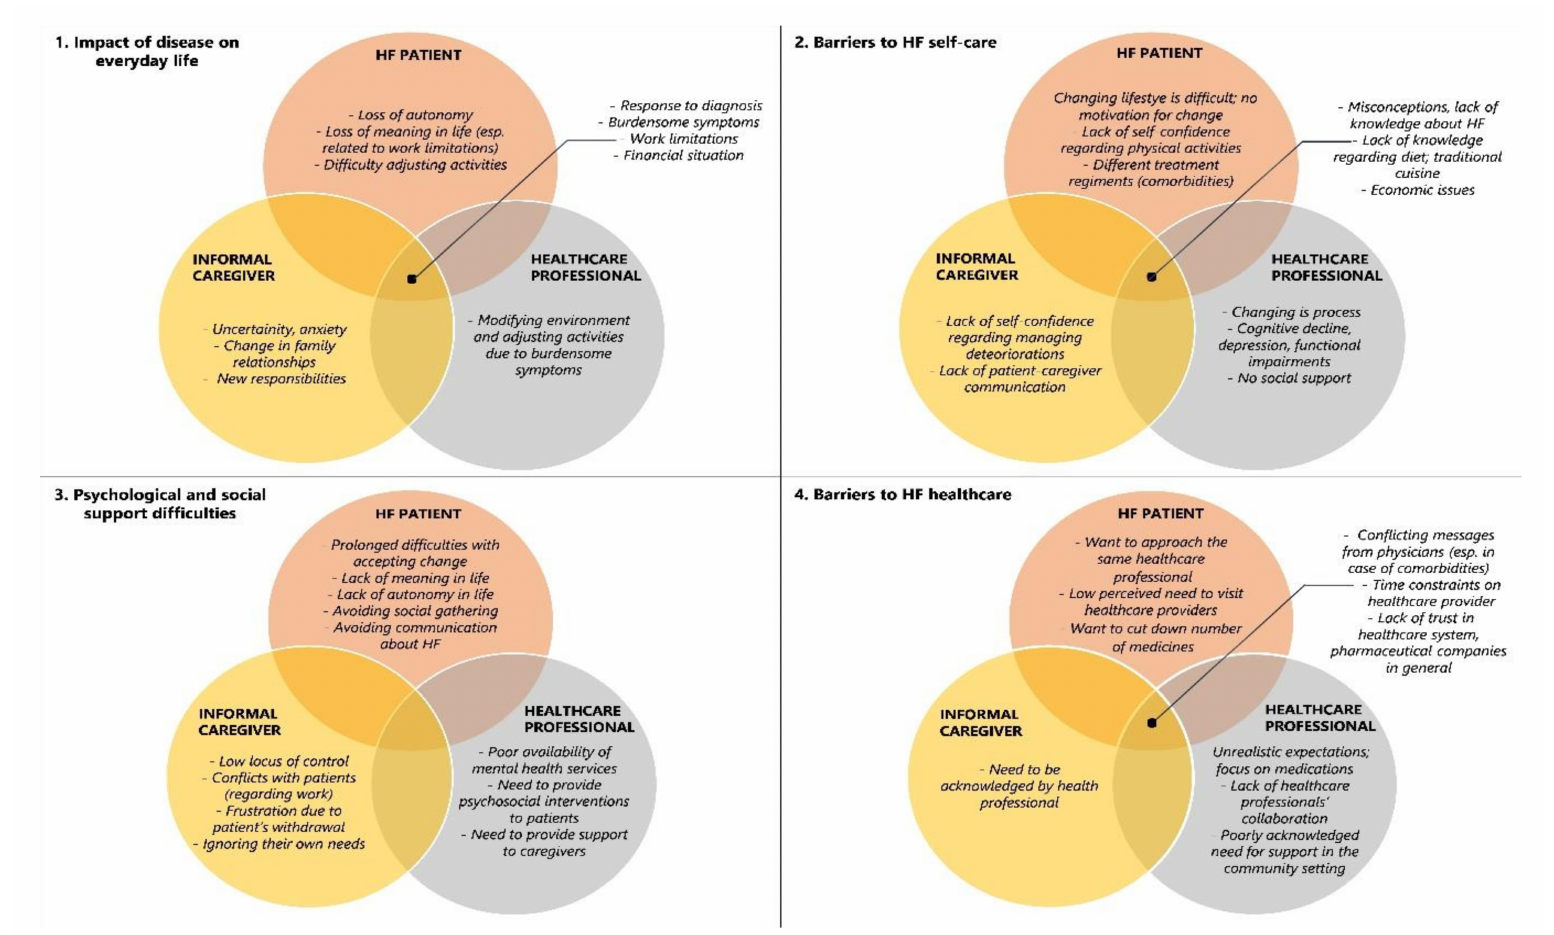
Figure 1. Descriptive summary of similarities and di ff erences in topics from interviews with patients, informal caregivers, and healthcare professionals. Within each domain of exploration, various similar and di ff erent topics emerged as relevant to the three interviewed